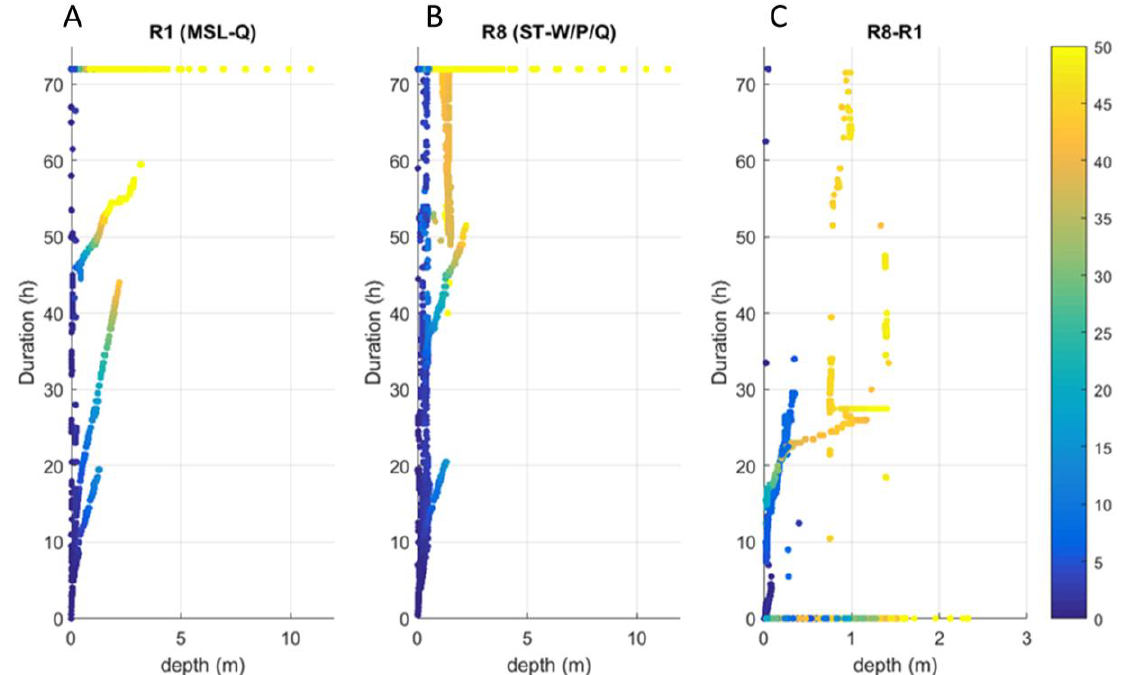
Figure 12. Changes in depth, duration, and hazard factor, F. Each point on the plot represents one 2-m grid cell in the Digital Elevation Model (DEM) and is positioned by the maximum water level (MXWL) experienced during the storm (x-axis) and the duration for which the cell was wet (y-axis). The plot is colored by the flood hazard factor ( F ). ( A ) Results shown for the modeled scenario account, R1 (5-year return period fluvial discharge). ( B ) Results shown for scenario R8 (same fluvial discharge in combination with a 7-year storm surge and spring tide). ( C ) The difference between scenarios R8 and R1.